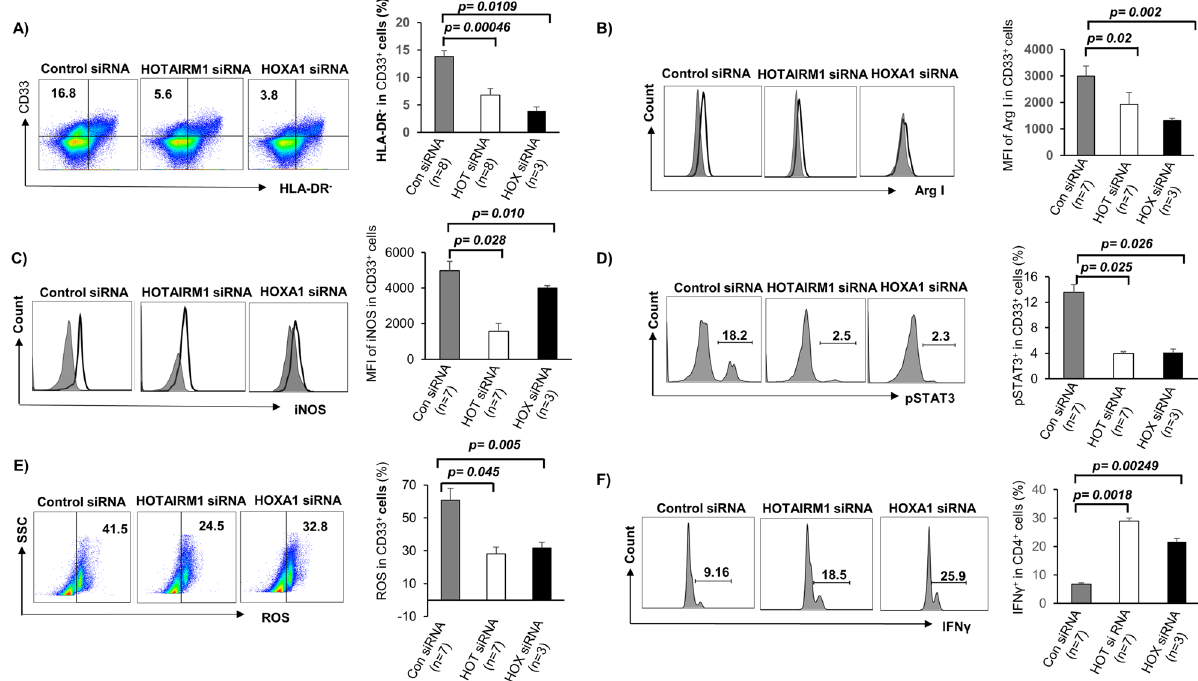
Figure 6. Silencing of HOTAIRM1 or HOXA1 expression in CD33 + cells from HCV-infected subjects abrogates MDSC differentiation and immunosuppressive functions. ( A ) siRNA-mediated knockdown of HOTAIRM1 or HOXA1 expression in CD33 + cells of HCV subjects inhibits CD33 + cell differentiation into MDSCs (determined by lower HLA-DR − cell frequency). ( B–E ) siRNA-mediated knockdown of HOTAIRM1 or HOXA1 expression in CD33 + cells of HCV subjects inhibits Arg1, iNOS, pSTAT3, and ROS productions. ( F ) Improved IFN-γ production by HCV CD4 T cells following incubation with autologous CD33 + cells with HOTAIRM1 or HOXA1